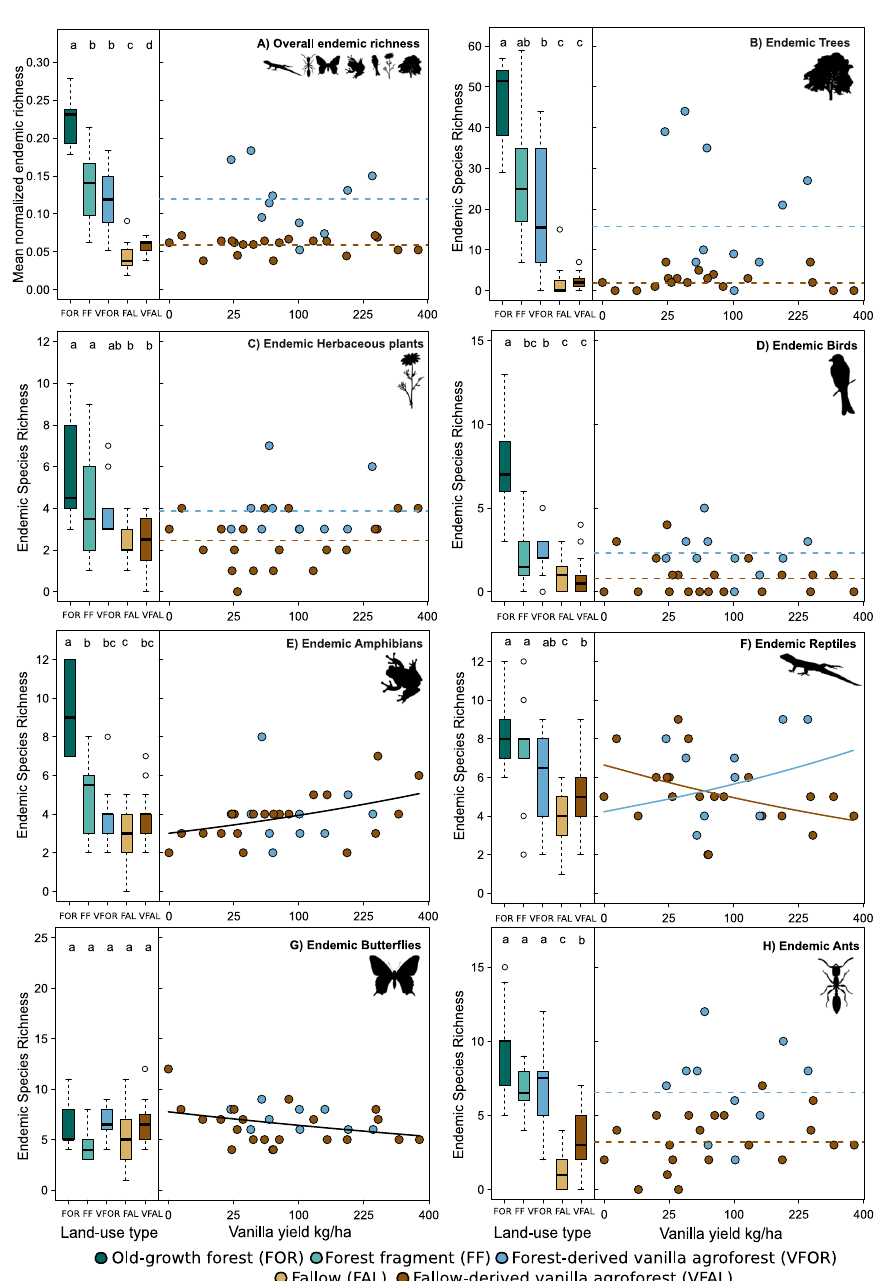
Fig. 2 Overall endemic species richness (mean normalized endemic richness across all taxa) and individual endemic species richness of seven taxonomic groups across land-use types and with increasing vanilla yield. Shown are boxplots of plot-level mean normalized endemic richness ( A ) and endemic species richness of seven taxa individually ( B – H ) in old-growth forest (FOR = dark green), forest fragment (FF = light green), forest-derived vanilla agroforest (VFOR = blue), fallow (FAL = yellow) and fallow-derived vanilla agroforest (VFAL = brown). n = 10 for FOR, FF, and VFOR & n = 20 for FAL and VFAL. The line inside the boxplot represents the median of each land-use type. The lower and upper boundaries of the boxplot show the 25th – 75th percentiles of the observational data, respectively, and the whiskers show the 1.5 interquartile range. Outliers are shown as dots. Letters indicate signi fi cant differences between land-use types based on pairwise Tukey ’ s honest or Wilcoxon signi fi cance tests (Statistical test results in Supplementary Tables 4 – 6). Scatterplots (VFOR = blue and VFAL = brown) show the relationship between plot-level mean normalized endemic richness ( A ) and plot level endemic richness of the seven taxa ( B – H ) with vanilla yield. Lines indicate model predictions (Statistical test results in Supplementary Tables 1 and 2). Horizontal dashed lines are intercept-only linear models (lines are based on the mean of the distribution). Solid lines indicate statistically signi fi cant relationships ( p < 0.05). Two colored lines (VFOR = blue and VFAL = brown) are shown as dashed lines if land-use history was signi fi cant as an additive term but there was no signi fi cant relationship between endemic species richness with vanilla yield. Solid colored lines indicate that the effect of vanilla yield was moderated by land-use history. Sample size: n = 70 plots for endemic herbaceous plants, birds, amphibians, reptiles, butter fl ies, and ants; n = 68 plots for trees; n = 30 plots for vanilla yield. Note the sqrt-scale for vanilla yield/kg. Icons from phylopic.org (see Supplementary Table 19 for attributions).